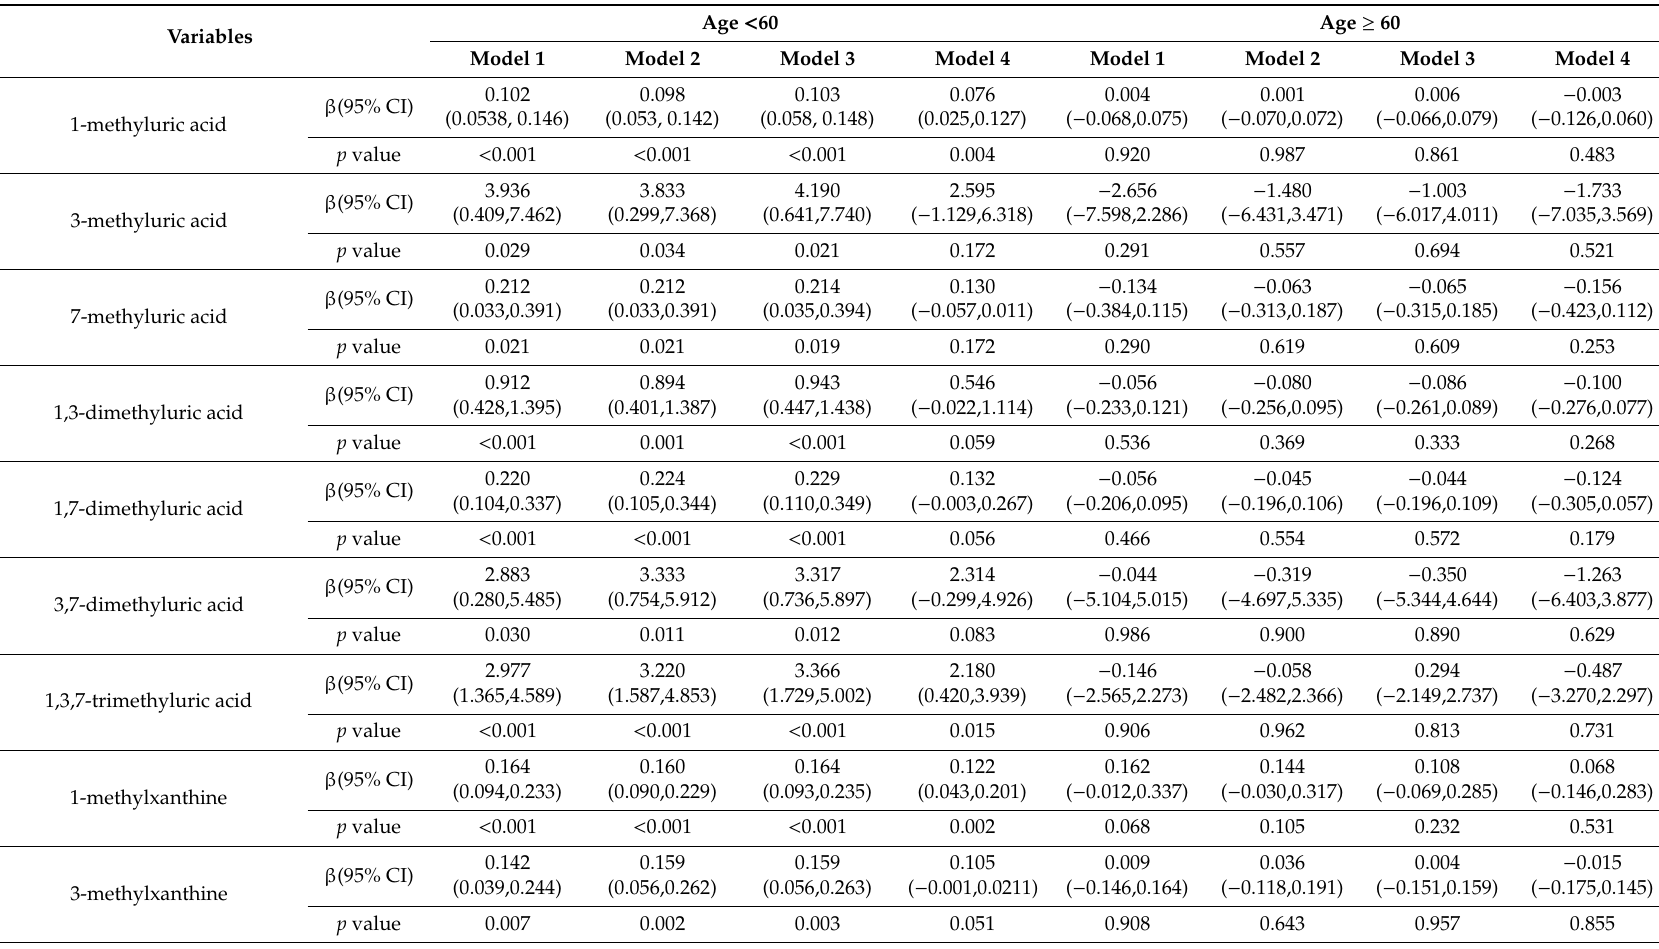
Table 4. Association between urinary ca ff eine metabolites and urine flow rate as categorized by